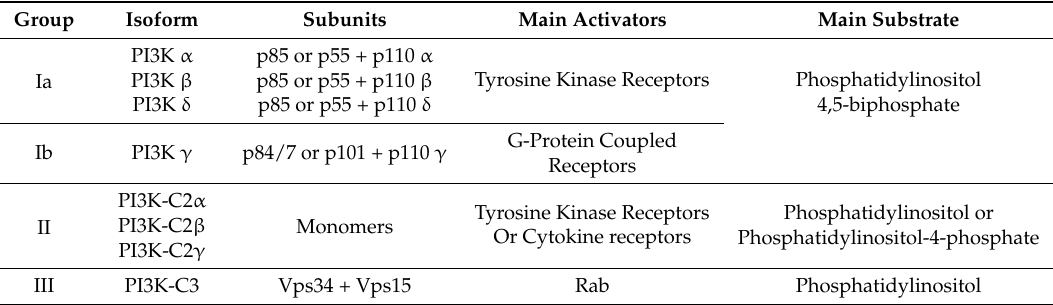
Table 1. Isoforms of Phosphoinositide 3-Kinase in